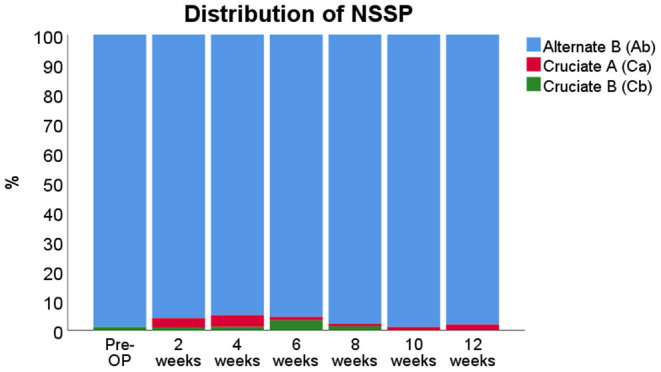
Distribution of Normal Step Sequence Patterns (NSSPs) before and after median nerve neurotmesis and autograft repair.